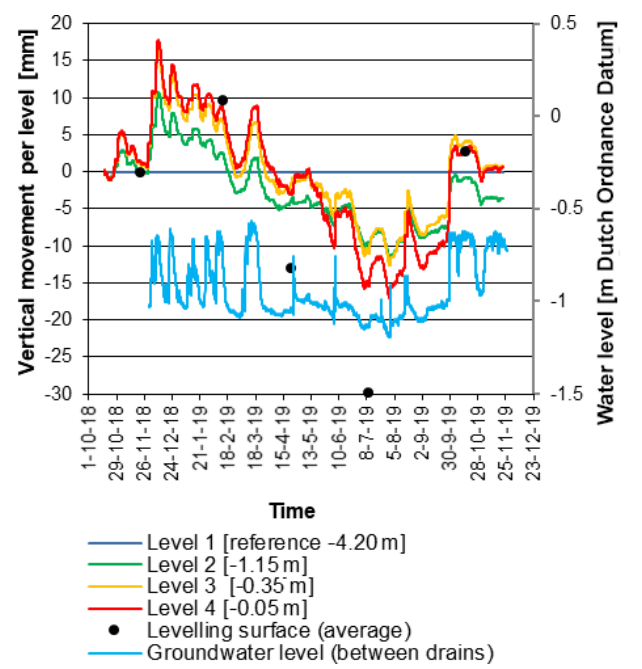
Figure 3. Preliminary results of extensometer, levelling and groundwater level measurements (parcel 05-DR; Fig. 1).